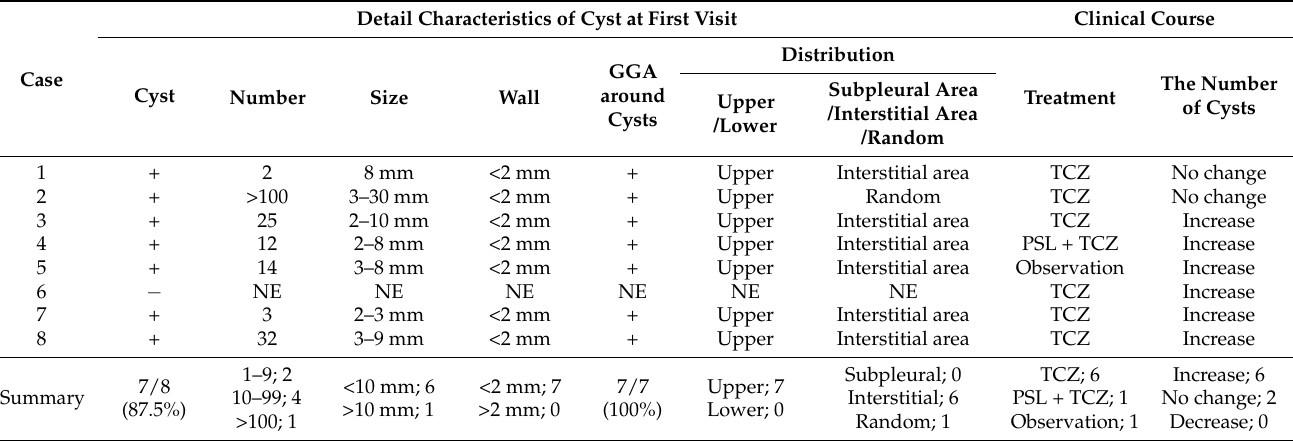
Table 3. Summary of characteristics of cysts.